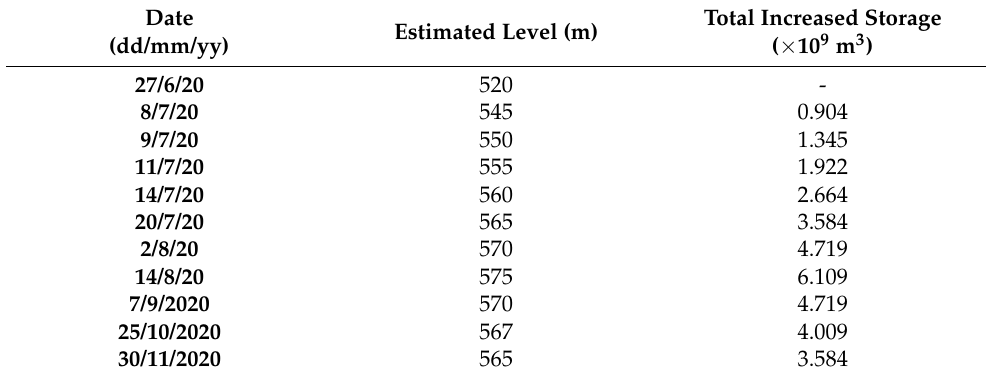
Table 1. Water level estimated from the digital elevation model (DEM) and corresponding volume of the